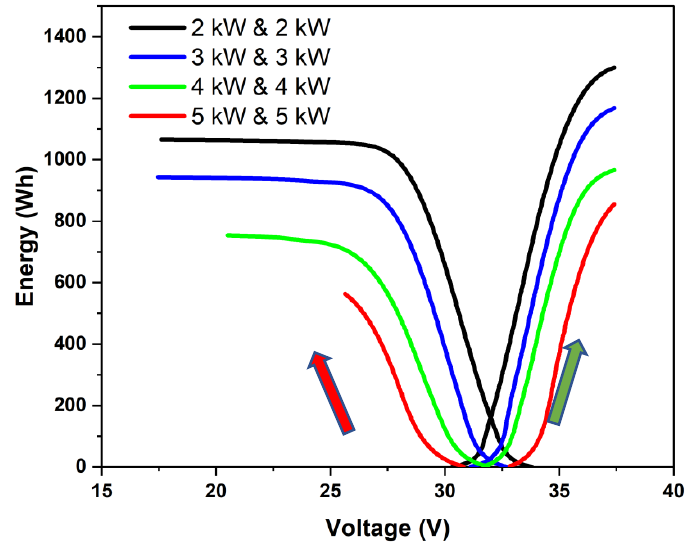
Figure 4. Stored energy vs. stack voltage during constant-power charge–discharge cycling at power levels of 2, 3, 4, and 5 kW. The stack was operated at set upper and lower voltage limits.